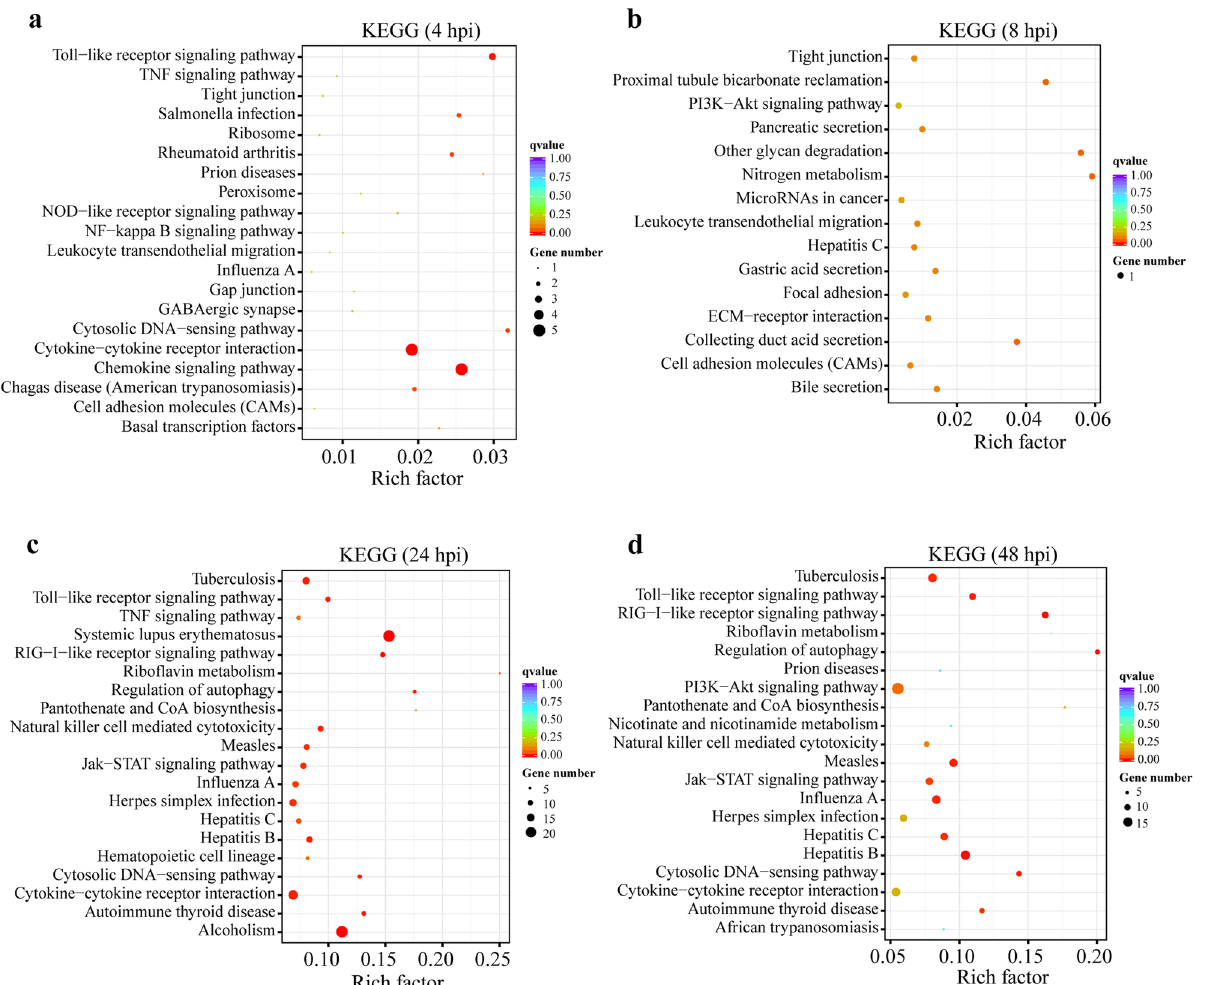
Figure 3. KEGG annotation of lncRNA target genes. KEGG pathway enrichment for cis predicted target genes of lncRNAs differentially expressed in RAW264.7 cells with infection of Brucella abortus S2308 for 4 ( a ), 8 ( b ), 24 ( c ) and 48 ( d ) h. A total of 20 significantly enriched pathways were shown in this figure and the Rich factor represents the ratio of lncRNA target genes to total annotated genes in a pathway (https:// www. kegg. jp/ kegg/ kegg1.